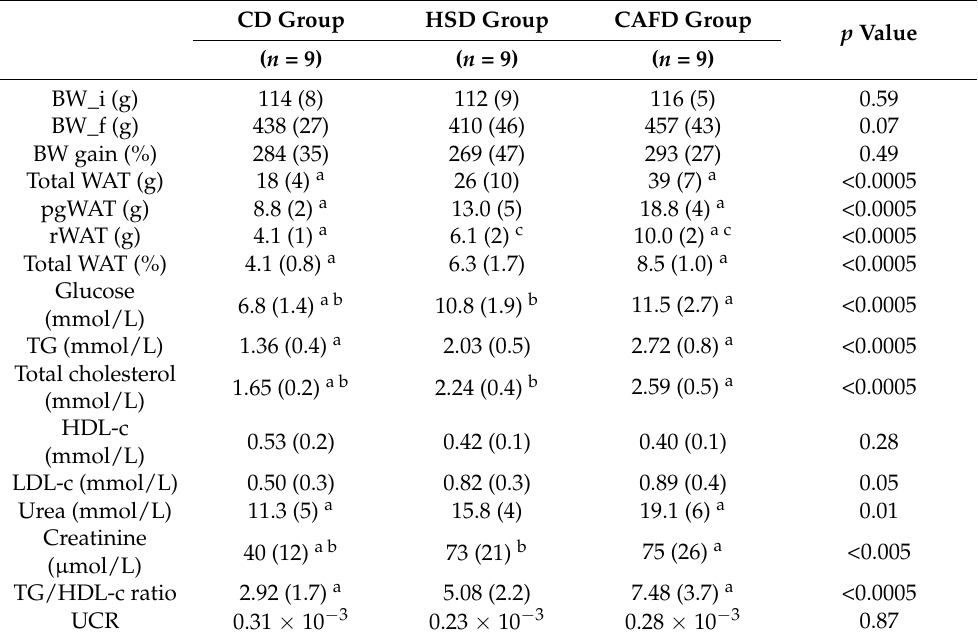
Table 1. Animal data and biochemical